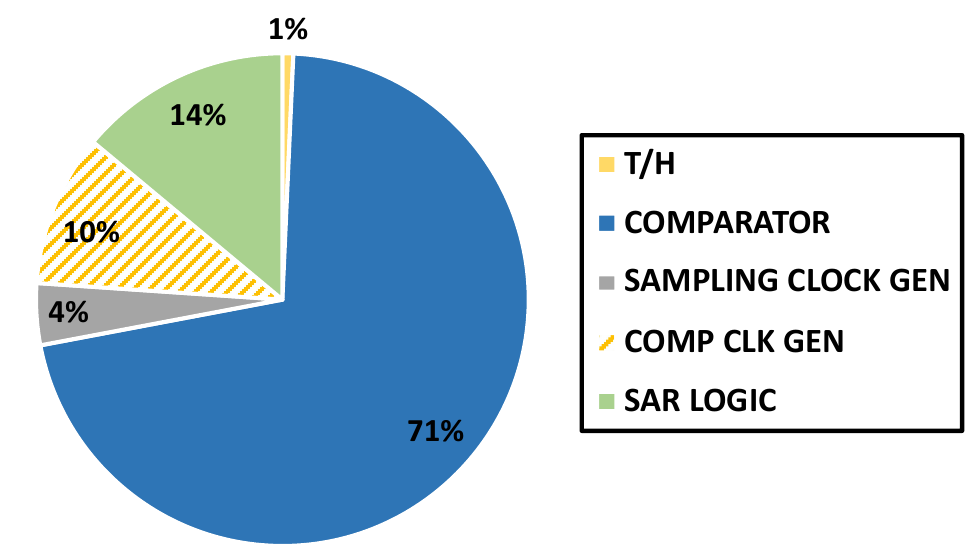
Figure 11. Layout design of proposed three-step tapered bit period clock generation in SAR ADC.